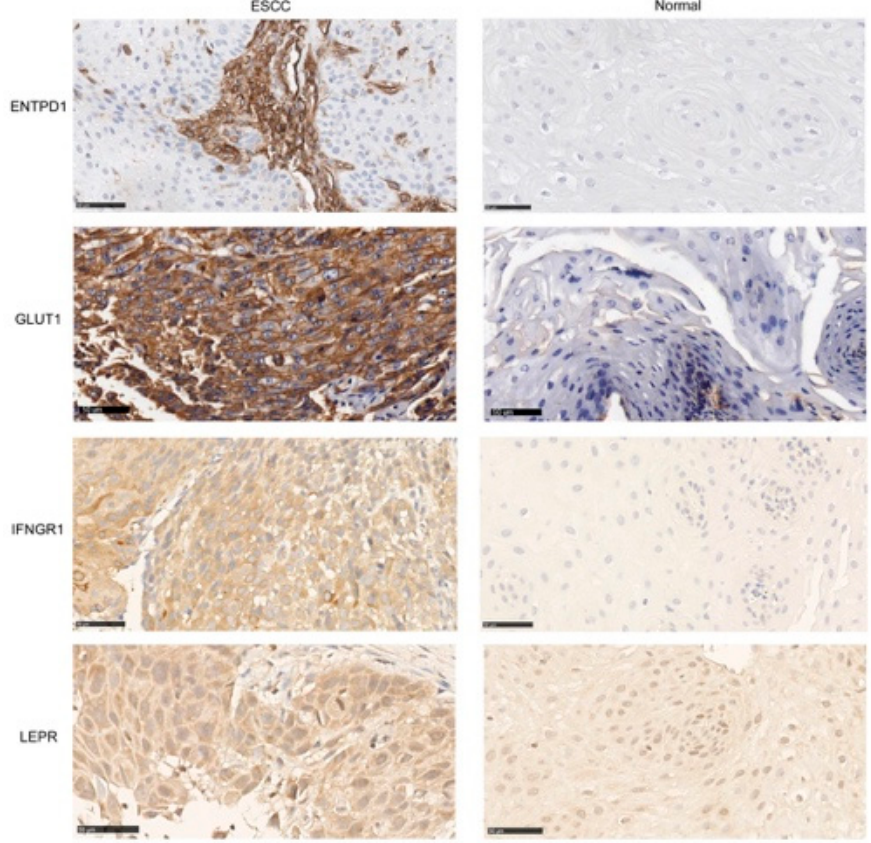
Figure 2. The validation of four candidate genes Representative images of anti-ENTPD1, anti-GLUT1, anti-IFNGR1, anti-LEPR IHC staining results (brown) in ESCC tissue and normal esophagus tissue. Bar: 50 μ m.